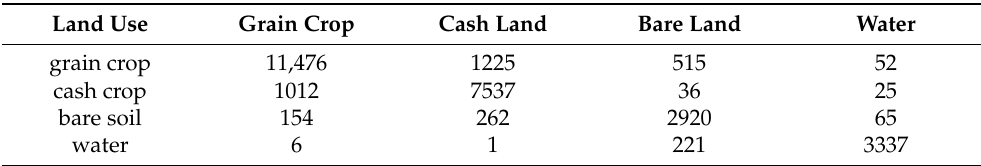
Table 5. Confusion matrix of crop classification obtained from SVM using the GLCM parameter dataset extracted from Sentinel-1 time-series dataset in 2015.